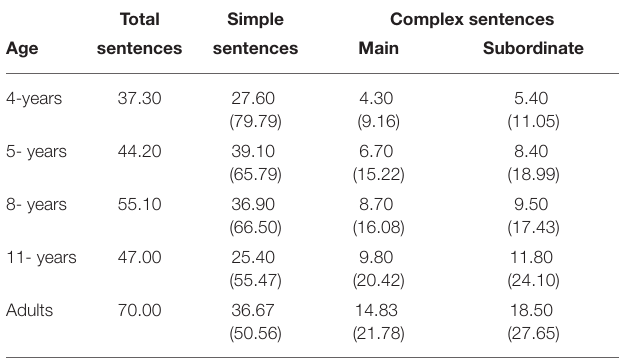
TABLE 3 | Frequency (and percentage) of complex sentences with 1-, 2- and 3-non-finite clauses (NCL) by age. Age Total